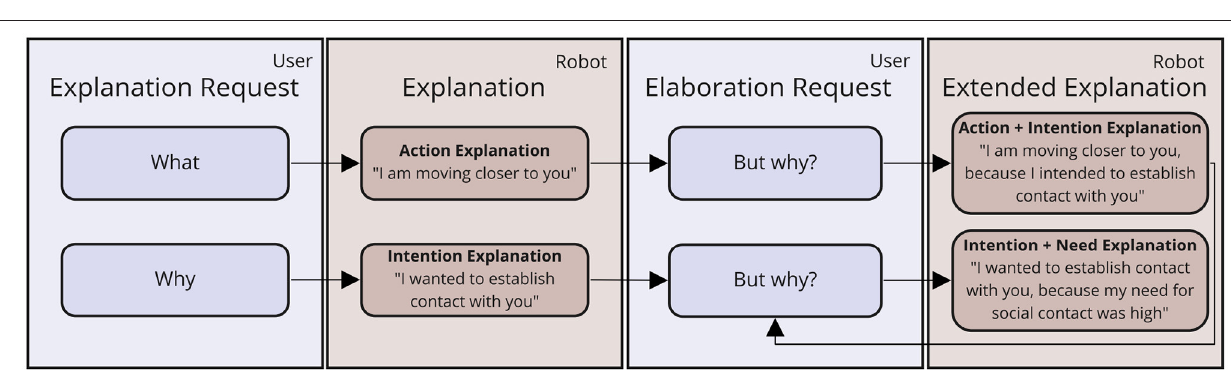
FIGURE 3 | Flow model of explanation dialogs in socio-interactive human-robot